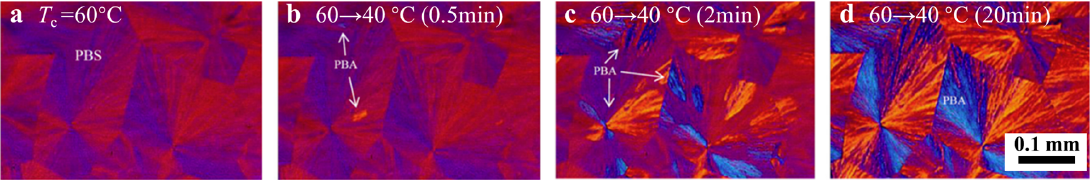
Figure 9. POM micrographs of PBS/PBA 50/50 blends. The blend samples were first cooled from 150 down to 60 °C for the crystallization of the PBS component ( a ) and then further cooled to 40 °C for the crystallization of the PBA component for ( b ) 0.5 min, ( c ) 2 min and ( d ) 20 min [94]. Copyright 2011. Reproduced with permission from Elsevier Ltd.